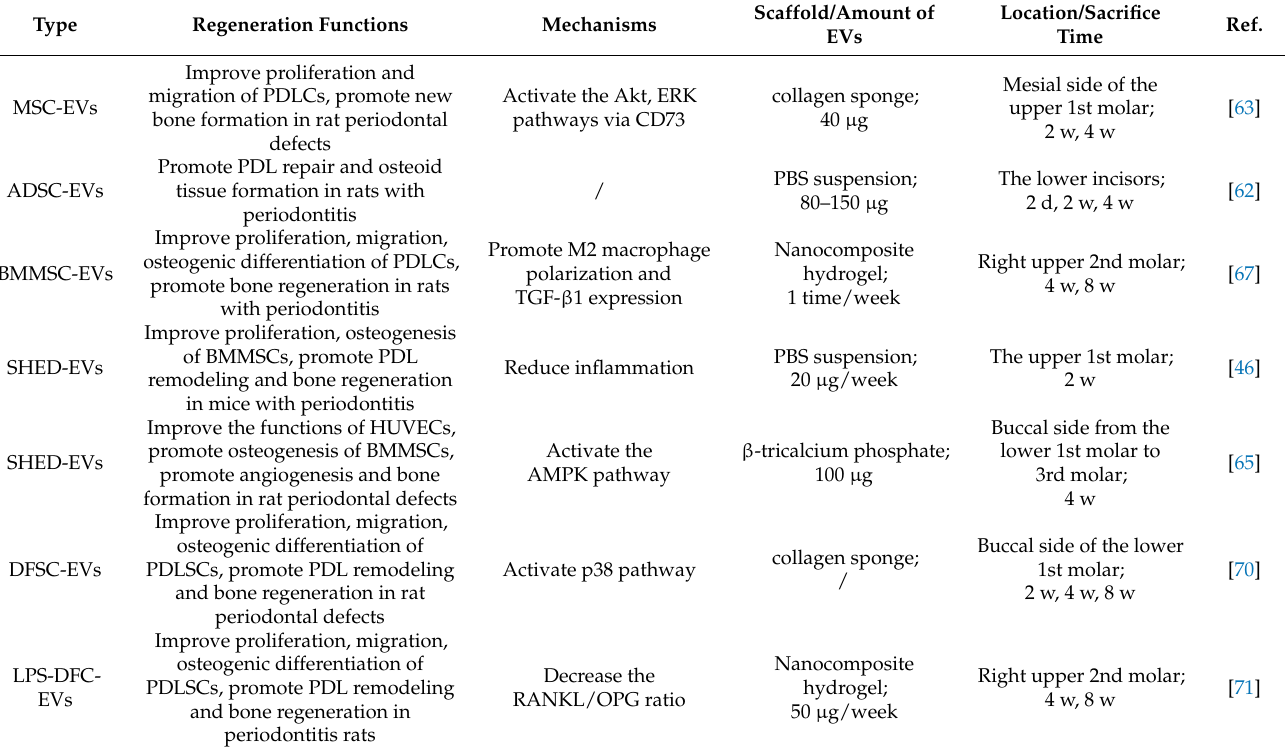
Table 1. Application of SCEVs and ICEVs in periodontal